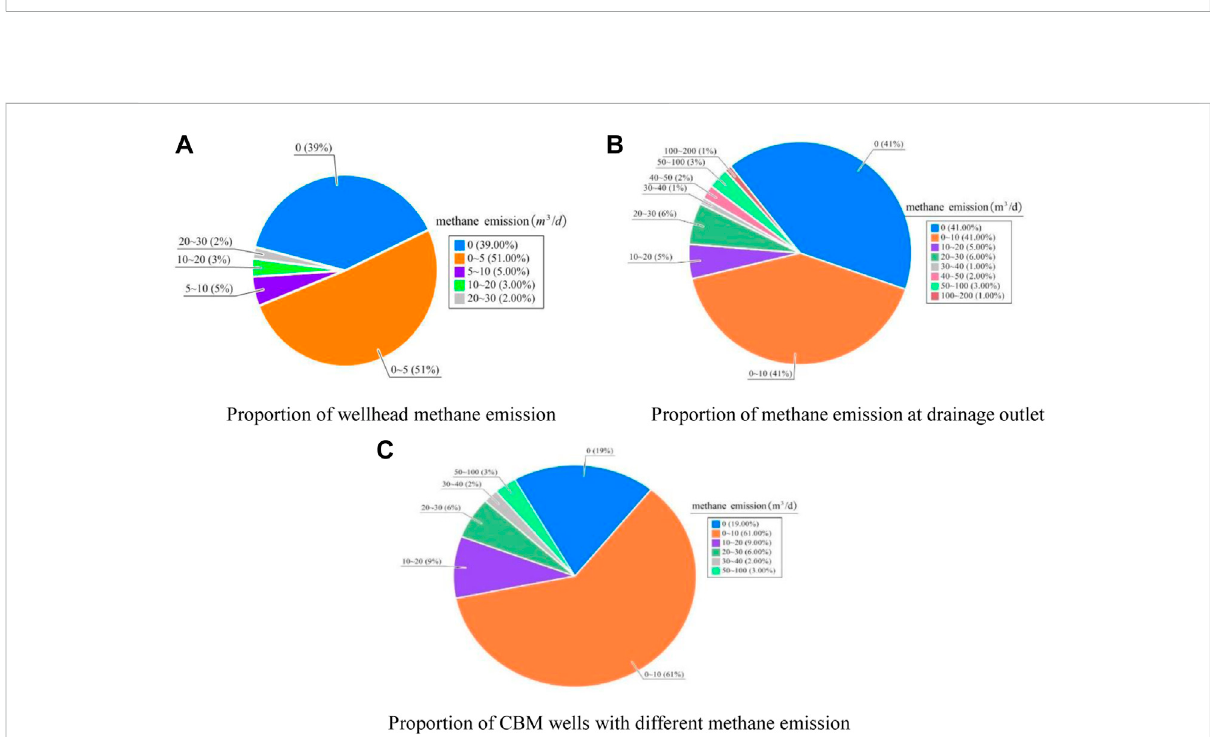
FIGURE 3 Change curve of methane volume fraction at drainage outlet of CBM